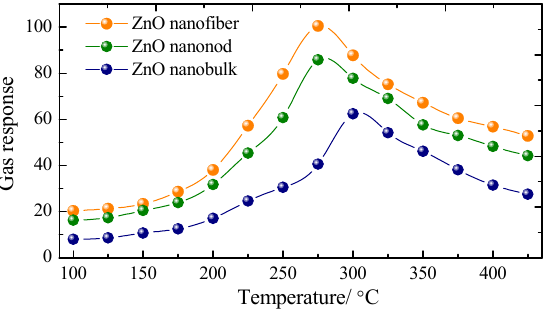
at different operating 4